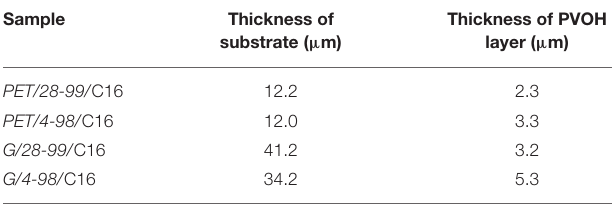
TABLE 1 | Results of thickness measurement from microtome cuts. Sample